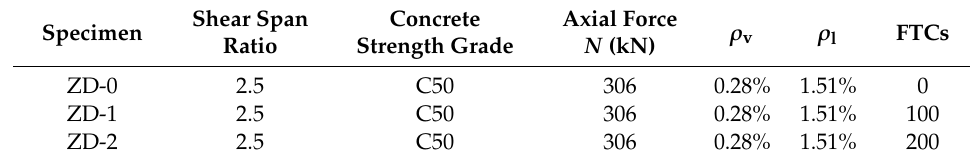
Figure 1. Specimen dimensions and section details. Table 1. Design parameters of